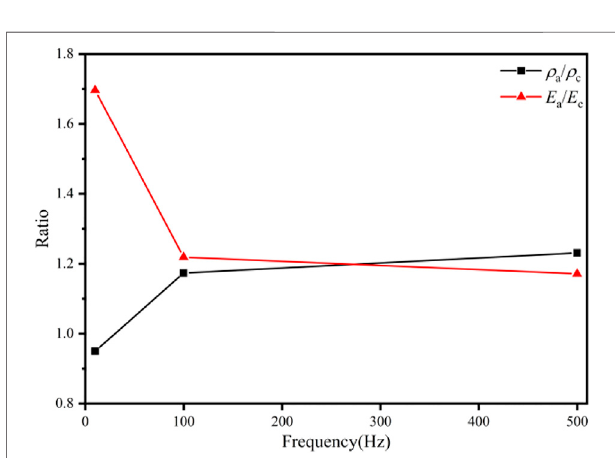
FIGURE 6 | Effect of Frequency on polarity effects of space charge and electric fi eld